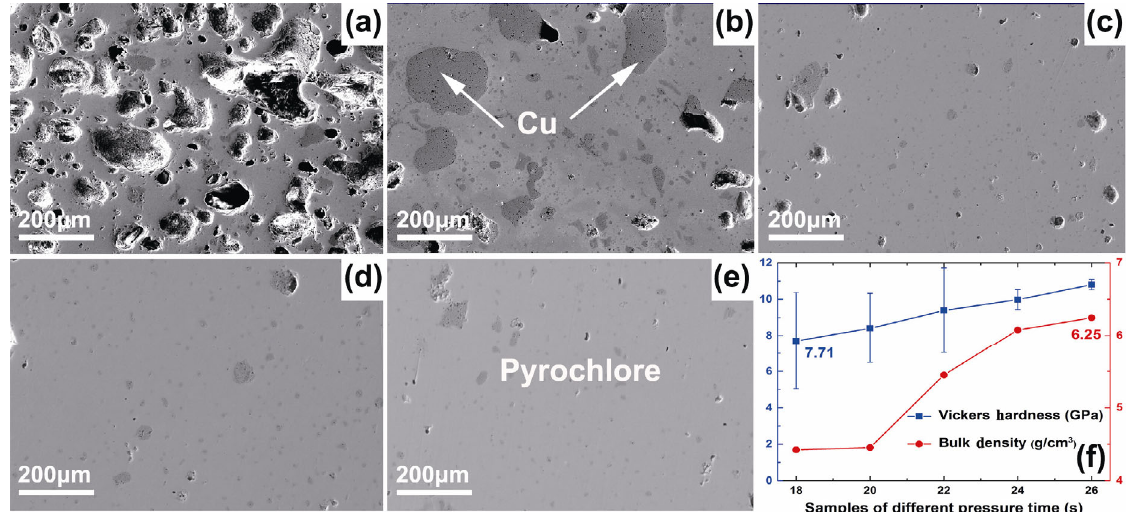
Fig. 5 BSE images of Zr-35 samples with different pressure time: (a) 18 s, (b) 20 s, (c) 22 s, (d) 24 s, (e) 26 s and (f) Vick s er hardness and bulk density of five